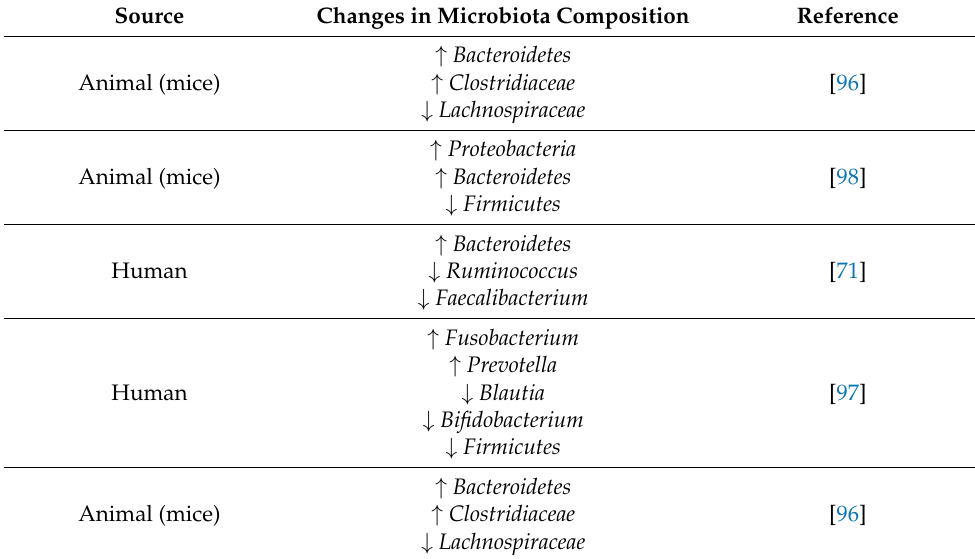
Table 2. Reported modification of the gut microbiota after first-line antibiotic therapy for